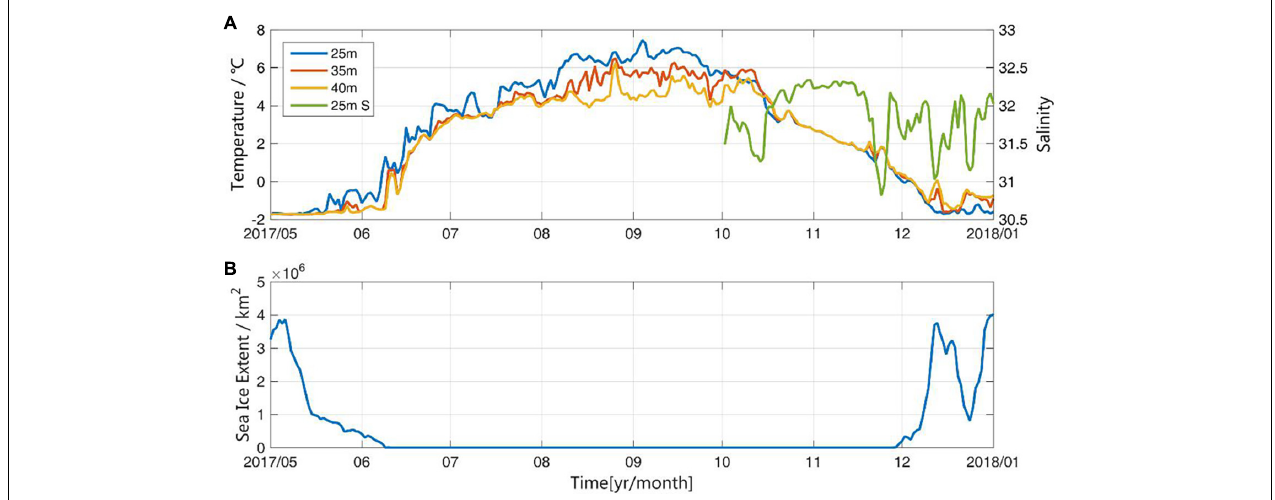
FIGURE 5 | Time series for (A) temperature ( 25-, 35-, and 40-m layers) and salinity (25-m layer), (B) sea ice extent calculated in 200 × 200 km boxes around the mooring